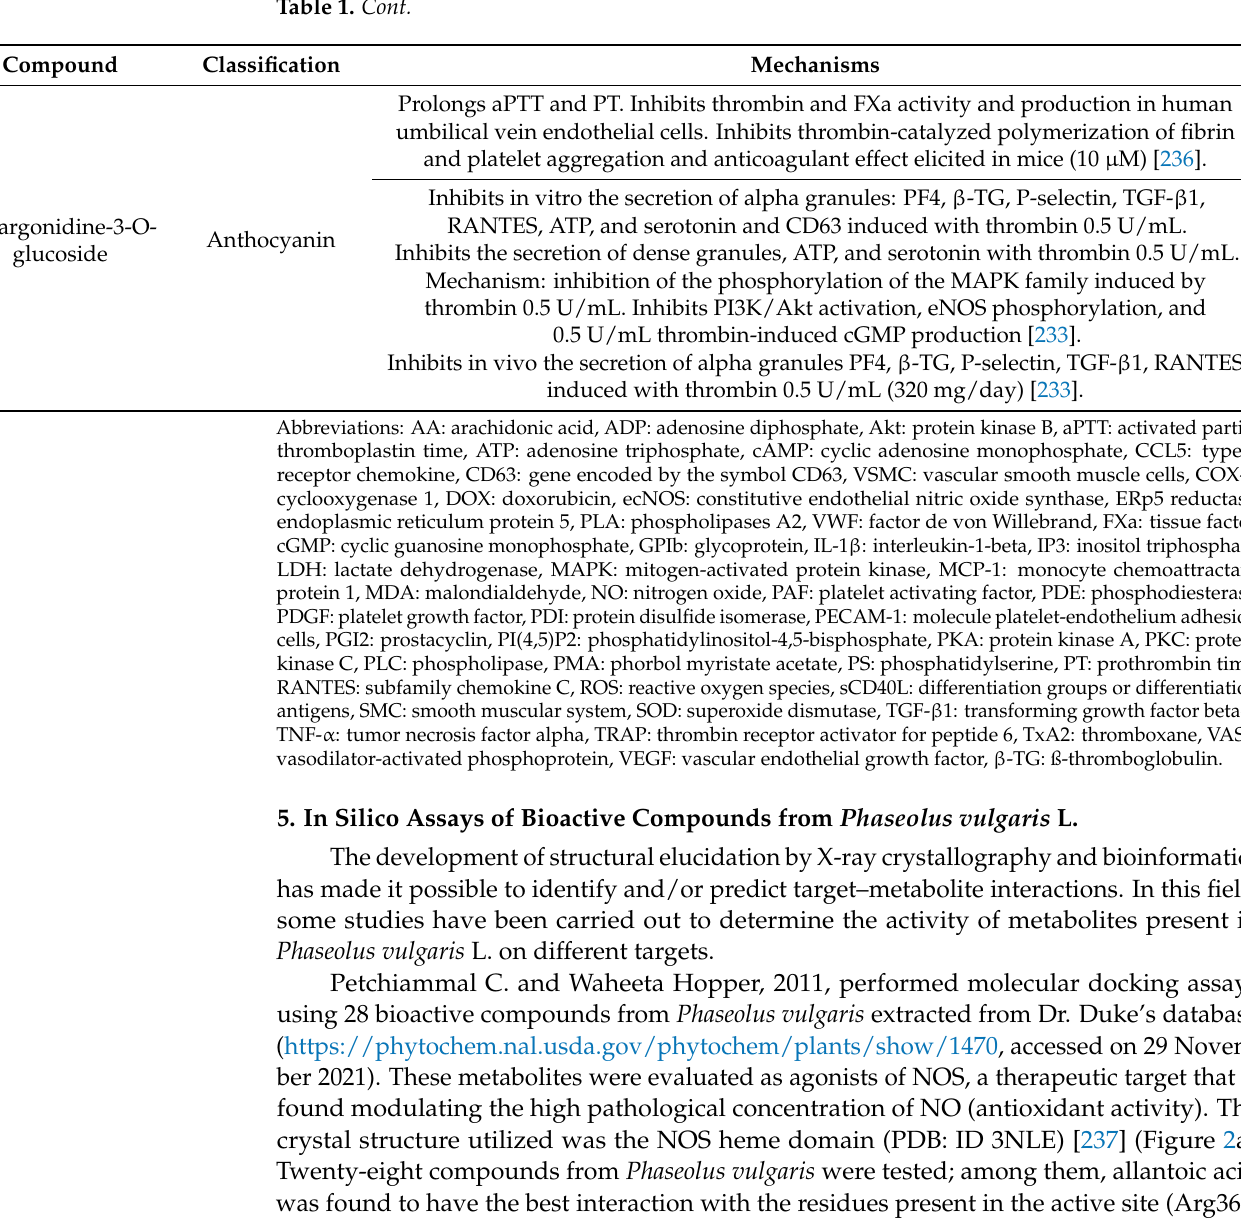
Table 1. Cont. Compound Classification Mechanisms Prolongs aPTT and PT. Inhibits thrombin and FXa activity and production in human umbilical vein endothelial cells. Inhibits thrombin-catalyzed polymerization of